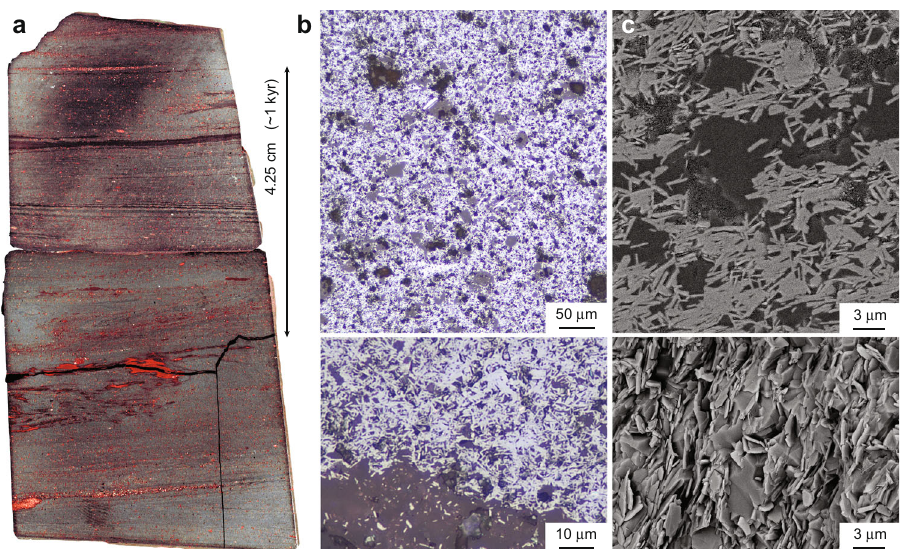
Fig. 6 Petrography of iron formation. a High susceptibility, hematite-pure hand sample (HOL-1) from Holowilena (Fig. 5b). Note red jasper is laterally discontinuous and interpreted to be chemically precipitated. b Photomicrographs under re fl ected light show randomly oriented euhedral hematite laths (white) in a quartz, chert, and clay matrix (gray). Note large gray intraclast at the bottom, also containing hematite laths. c SEM images of polished thin section (top) and rock chip (bottom) exhibiting randomly oriented hematite laths in two and three dimensions, respectively. The textures strongly suggest that the hematite is authigenic (i.e., chemically precipitated) and not and BIF3 (bottom in Supplementary Fig. 11) was detrended with a degree-3 Hysteresis loops of the samples were measured at 5-mT fi eld steps, with the applied fi eld ranging between − 1T and + 1T. Thermal susceptibility results are shown in polynomial fi t, which likely represents a millennial-scale cycle. Fig. 5. All other rock magnetic experiments are summarized in Supplementary Fig. 10. Oraparinna rock magnetic samples come from BIF080, 76m level (Figs. 2, Time series analysis . We conducted time series analysis using the Fast-Fourier 5a); BIF085, 71m level (Figs. 2, 5a); BIF100, 56m level (Figs. 2, 5a). Holowilena rock transform (FFT) 41 to test for the presence of any signi fi cant magnetic susceptibility magnetic samples come from ( − 31.987226°N, 138.849969°E): BIF006, lower 5 m of cycles. Spectral analyses were conducted in the stratigraphic domain, which yielded BIF in Holowilena logged section (Supplementary Figs. 1, 8; Fig. 5b); HOL-1, upper a set of spectral peaks representing cycles per stratigraphic meter. For the FFT, the 5 m of BIF in Holowilena logged section (Fig. 5b; Supplementary Fig. 8). spectral power used is the complex conjugate of the Fourier coef fi cients, normal- ized to unit mean power 41 . We evaluated the signi fi cance of the FFT spectral peaks Data availability using a Monte Carlo routine to simulate noise 41 . FFTs were performed on each of All magnetic susceptibility data are provided in Supplementary Tables 1 and 2. these 1000 randomly generated time series; a 95% con fi dence level was approxi- mated for each frequency by calculating three times the mean power 41 . We interpret spectral peaks rising above this 95% con fi dence level as statistically sig- ni fi cant, a commonly used statistical threshold for identifying non-random occurrences. Based on the FFT results, we ran bandpass fi lters with Gaussian windows to encapsulate the signi fi cant peaks identi fi ed. Amplitude modulation of a bandpass, if present, was analyzed using the approach of Grippo et al. 42 in which a Hilbert transform is used to fi nd the enveloping curve of a bandpass signal (in the time domain); an FFT was performed on the enveloping curve to identify the cycles of amplitude modulation of the shorter-wavelength signal. Since eccentricity is recti fi ed as climate change by its amplitude modulation of precession 1 , the Hilbert transform can test for evidence of such diagnostic spectral behavior. Observed cycles in the stratigraphic domain were converted into the time domain by assuming a sediment accumulation rate considered reasonable for Cryogenian strata in the Flinders Ranges (see main text). Resulting observed cycle periods were then compared to target cycle periods based on models of solar system evolution. Due to decelerating rotation and increasing Earth-moon distance, respectively, both precession and obliquity are expected to systematically lengthen over geologic time 27 (Supplementary Fig. 9; Supplementary Table 3). On the other hand, the periods for short (95 and 124 kyr) and long (405 kyr) eccentricity are considered constant “ metronomes ” 1,23 . After using the inferred range of feasible sediment accumulation rates of 3.7 to 4.4 cm kyr − 1 as an initial guideline (see main text), we selected the sediment accumulation rate for each stratigraphic section that yielded the minimum net mis fi t 43 between all observed cycles and their respective target cycles (Supplementary Table 3). Rock magnetic experiments . Selected samples from Oraparinna and Holowilena were ground to a fi ne powder. Magnetic susceptibility of the samples was monitored on heating from room temperature to 700°C and subsequent cooling to room temperature (at heating and cooling rates of ~11°Cmin − 1 ) using an AGICO KLY- 4S Kappabridge Susceptibility instrument. A portion of these samples were also used for room temperature isothermal remanent magnetization (IRM) acquisition and hysteresis loop experiments on a Princeton Measurements Corp. Model 3900 Vibrating Sample Magnetometer (VSM). IRM of the samples was acquired and measured at sixty fi eld steps on a logarithmic scale ranging from 1 mT to 1T.